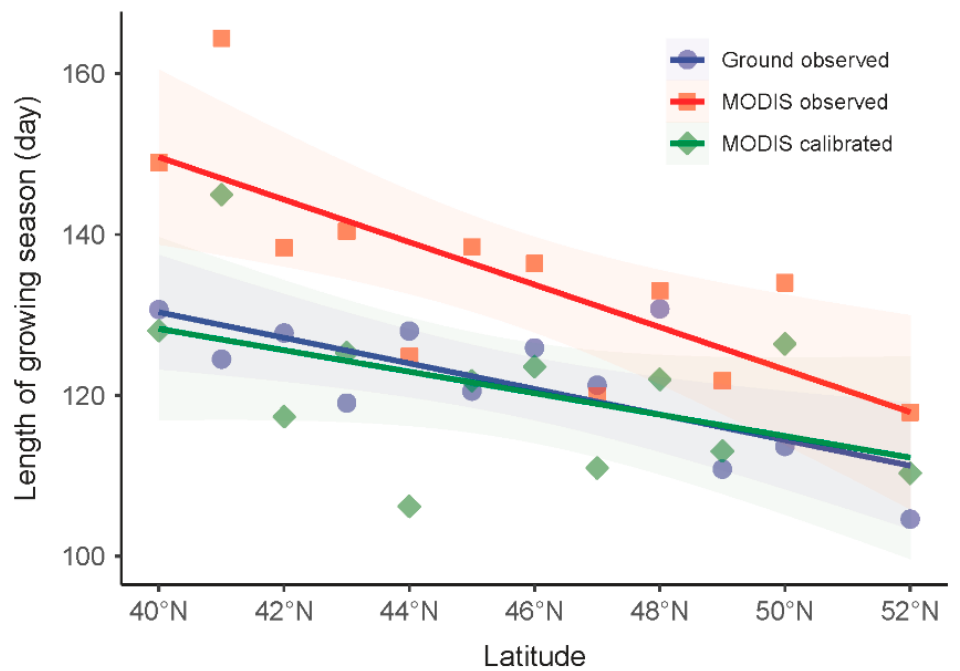
Figure 11. The relationship between the length of the cropland growing season (LOS) and the latitude in Northeast China from 2001 to 2010. The regression equations of the trend lines are: y = 175.72 − 1.19 x for ground-observed LOS, y = 270.75 − 2.98 x for MODIS-observed LOS, and y = 197.84 − 1.68 x for climotransfer function-predicted LOS, p <